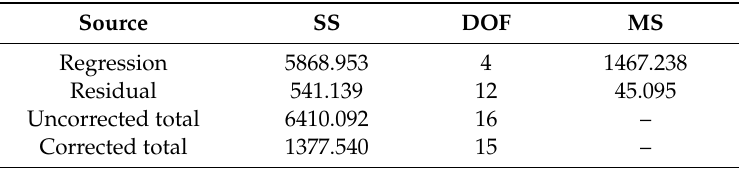
Table 4. ANOVA for the power function model of α X .